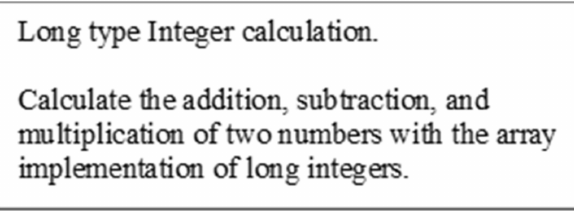
Figure 13. Test question